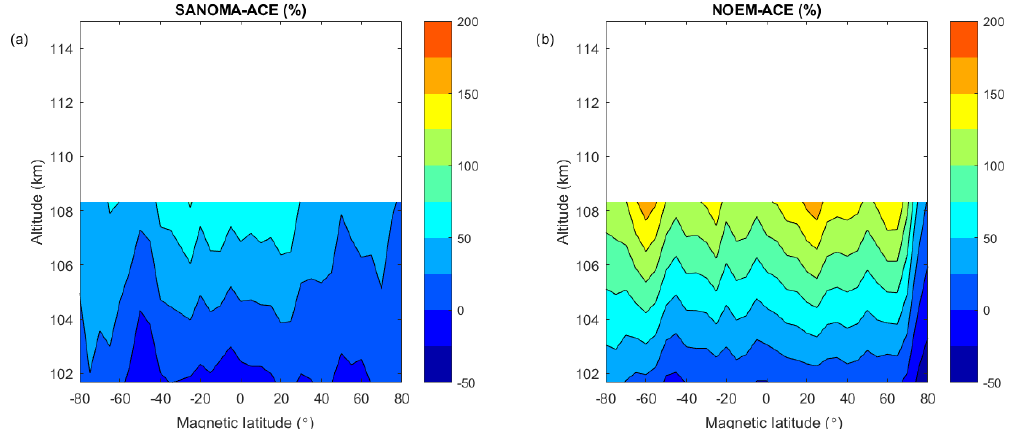
Figure 20. (a) Median difference between SANOMA and ACE as a percentage of mean ACE NO number density. (b) Median difference between NOEM and ACE as a percentage of mean ACE NO number density.